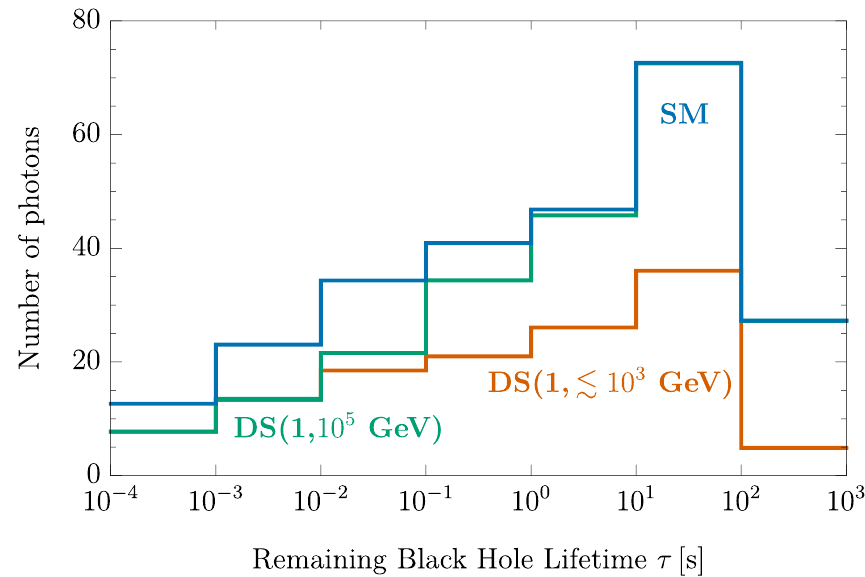
Figure 3: The number of photons observed in each time window for an EBH observed at 0.01pc for the SM and dark sector models at different mass